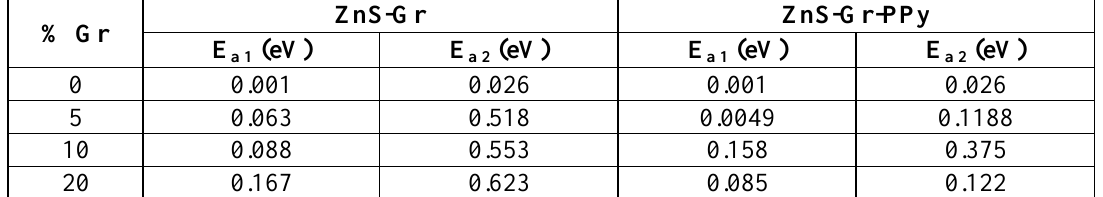
Table 2: D.C. Conductivity Parameters for pure ZnS and ZnS with different volume ratio (5, 10, 20)% of Gr.